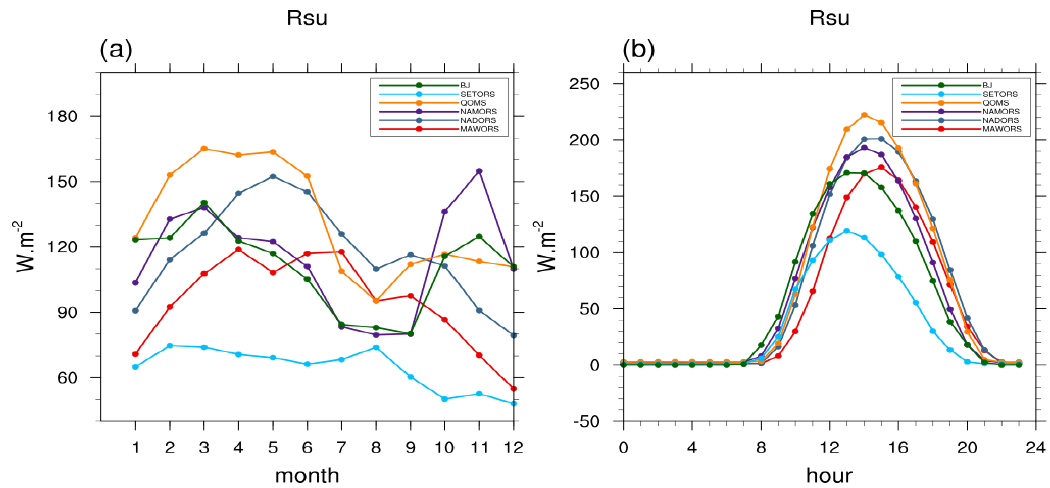
Figure 8. Annual variation of upward shortwave radiation ( a ) and diurnal variation of upward shortwave radiation ( b ) at each station.